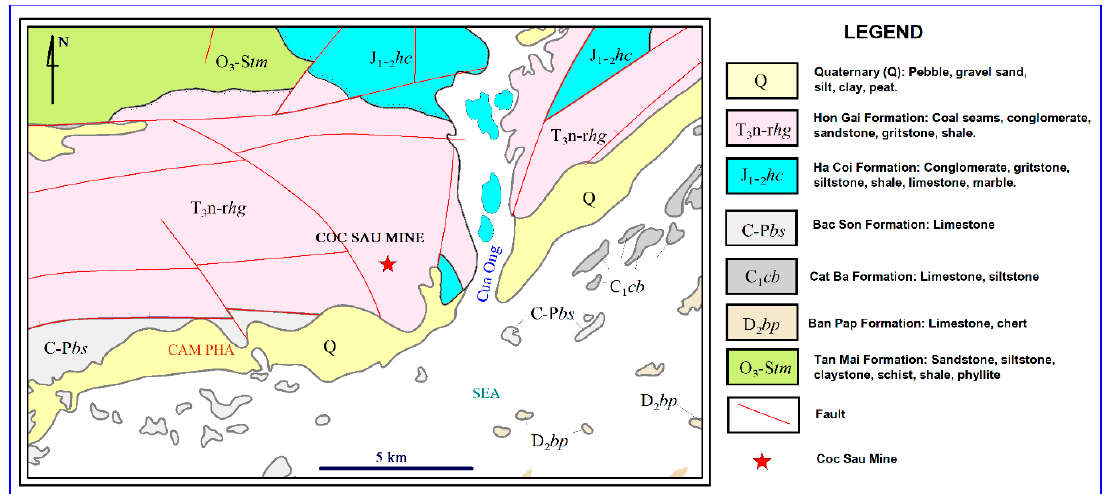
Figure 2. Simplified geological conditions of the Coc Sau open-pit coal mine.